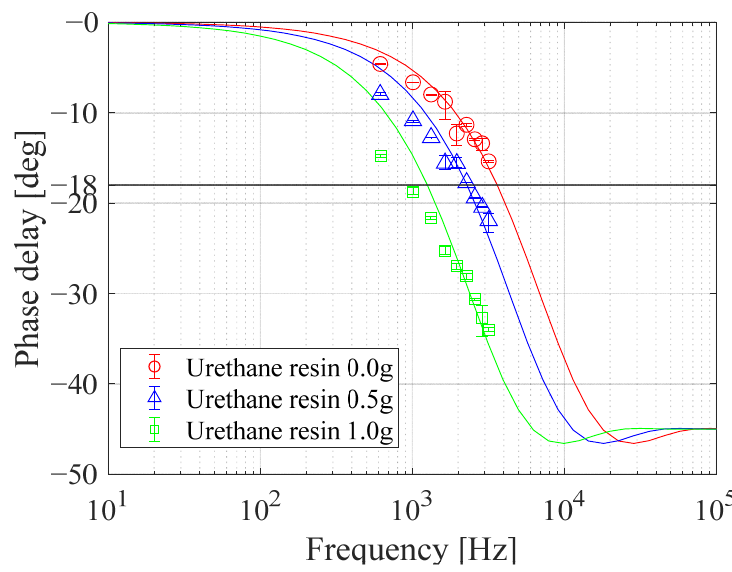
Figure 19. The frequency response diagrams of PC-PSP with different amounts of urethane resin.